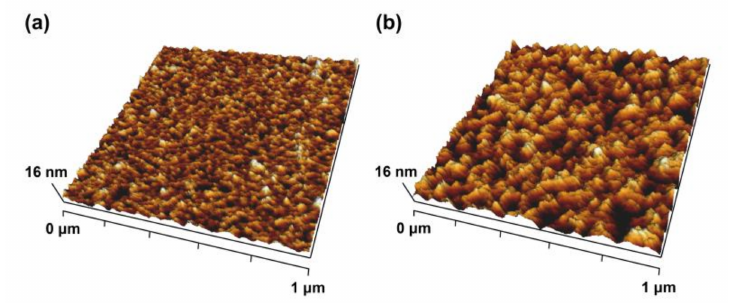
Figure 6. Atomic force microscopy (AFM) images of the AlN thin film on ( a ) the Mo elec- trode/sapphire substrate and ( b ) the Mo electrode/SiO 2 /Si substrate.